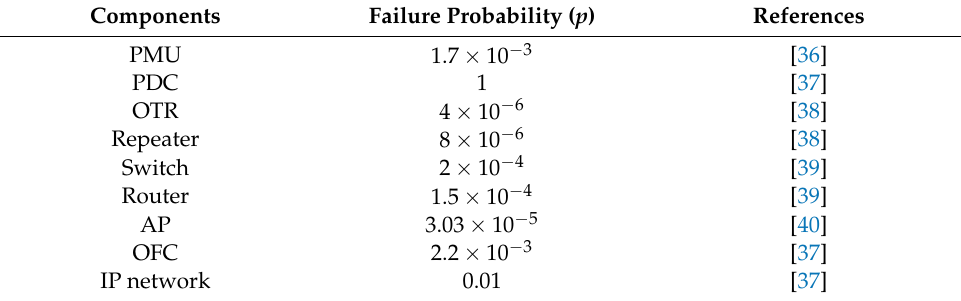
Table 1. Key components with failure